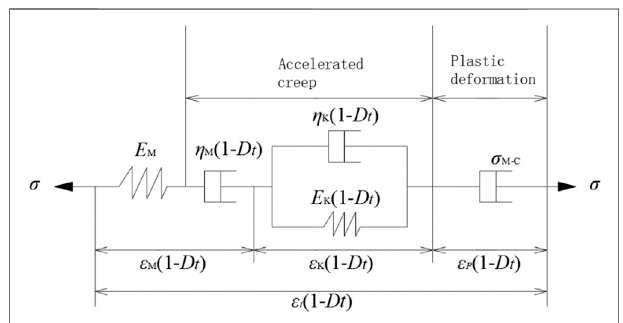
FIGURE 2 | Cvisc viscoelastic-plastic model considering